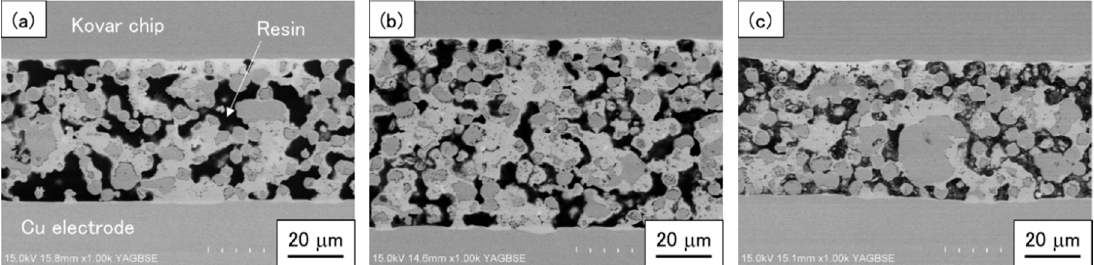
Figure 7. Cross-sectional SEM images of a TLPS joint aged at ( a ) 150, ( b ) 175, and ( c ) 200 °C for 1000 h.